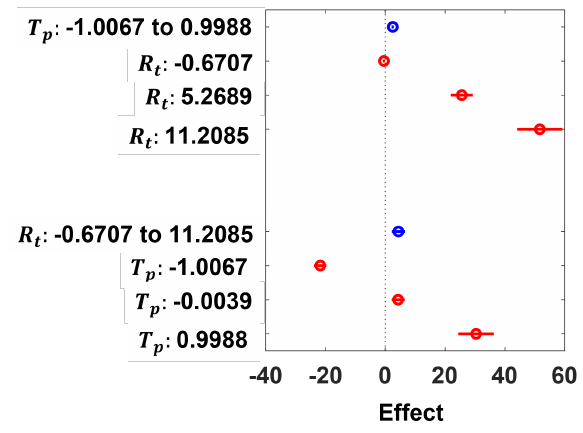
Figure 11. Interaction effect: T p and J t metrics for all the SDN scenarios.